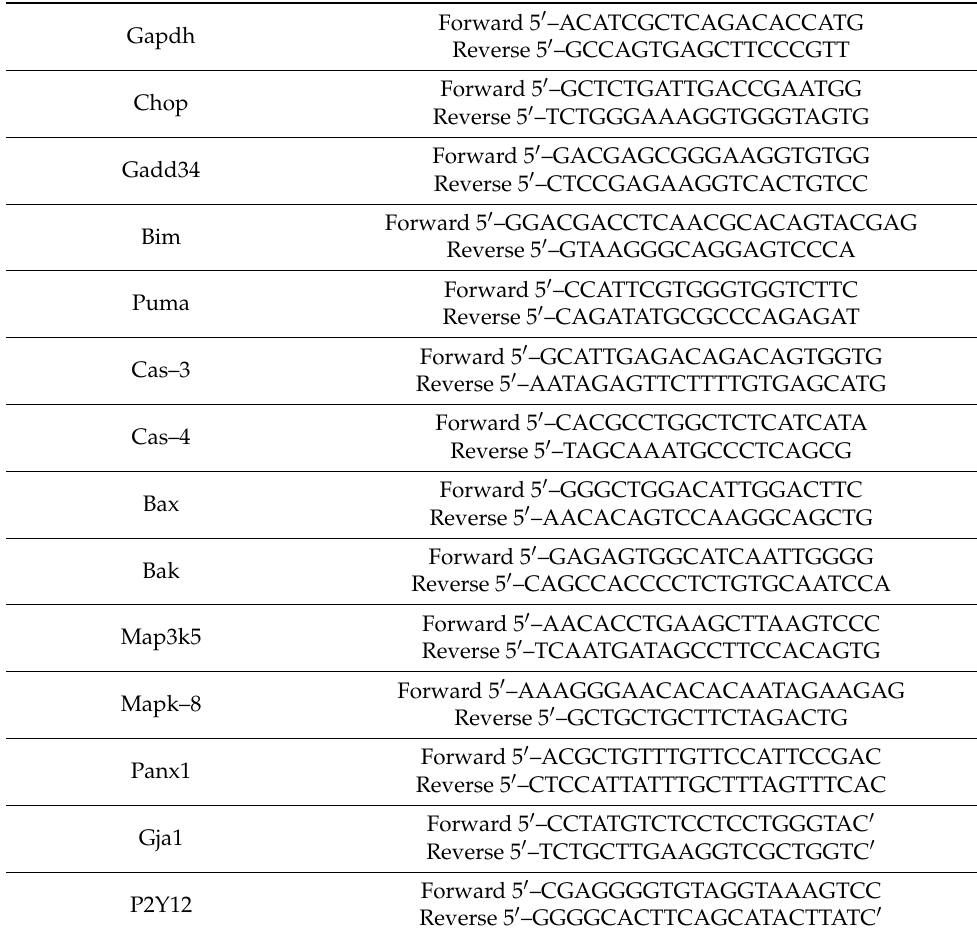
Table 1. Primer sequences for real-time polymerase chain reaction